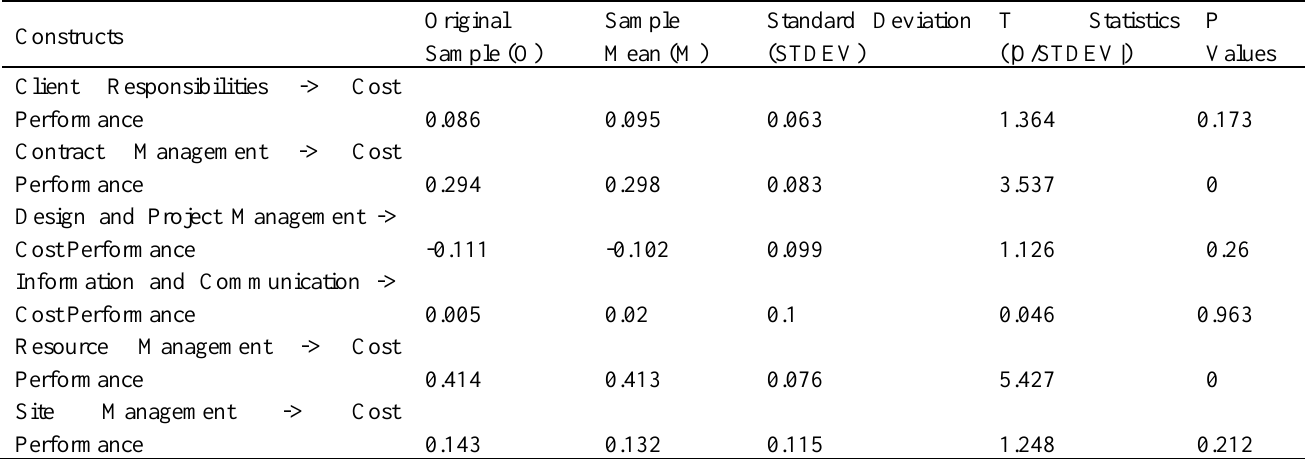
Bootstrapping Analysis (Path analysis and Hypothesis